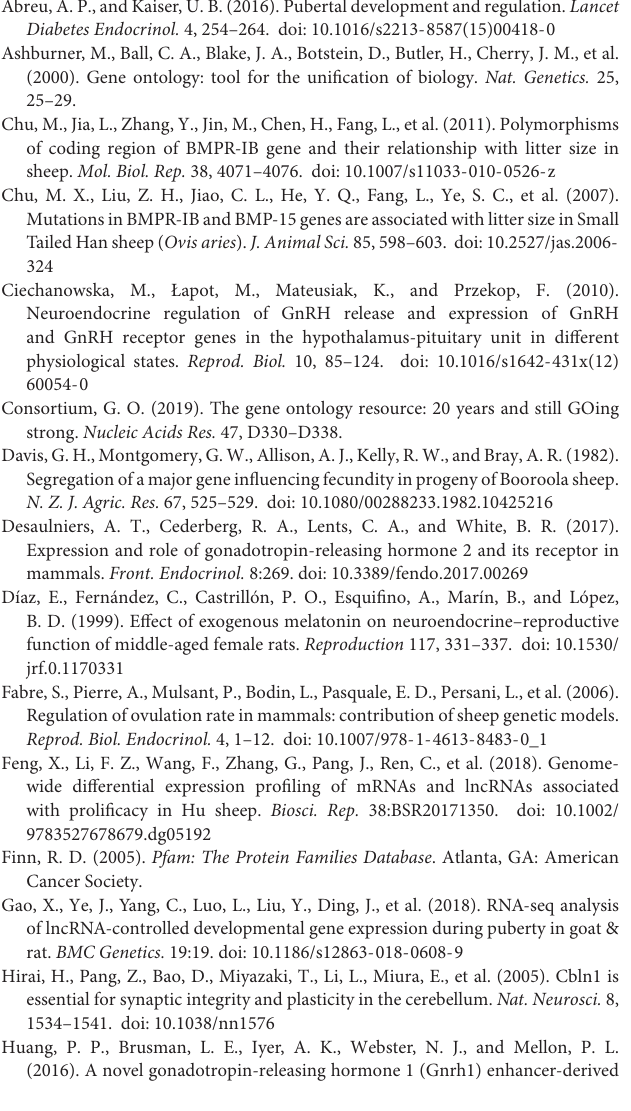
Supplementary Table 8 | The sequence of DE lncRNAs. Supplementary Table 9 | The code of DESeq2 and